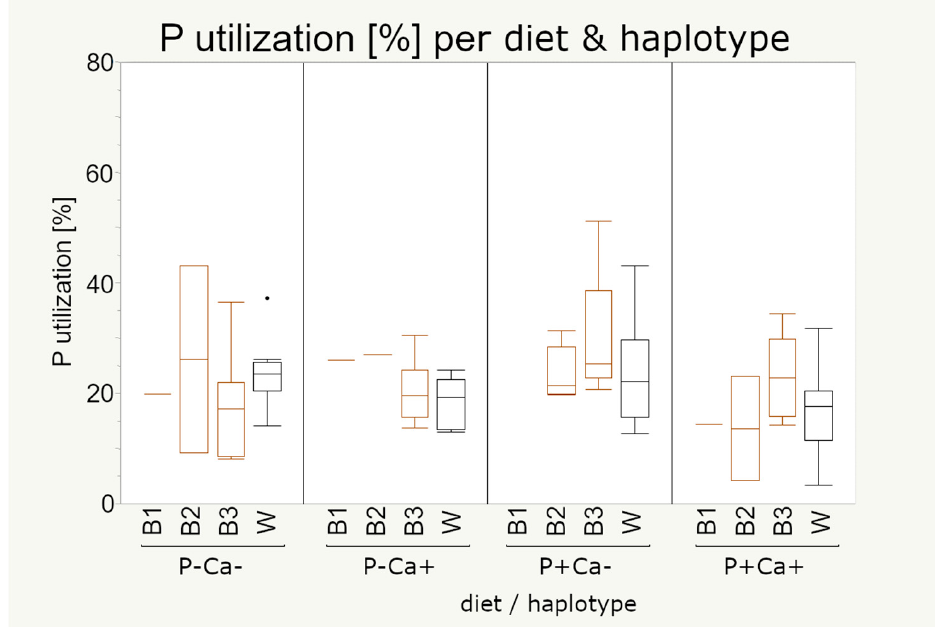
Figure 6. Phosphorus utilization (%) of 80 laying hens by haplotype and diet (experiment 2). Boxes represent 50% of the data points (median with interquartile ranges) whiskers show minimum and maximum. Sample numbers are given in Table 4. Statistical significance was declared when p < 0.05. P utilization data were first studied by Sommerfeld et al. 2020b [28] in the context of strain